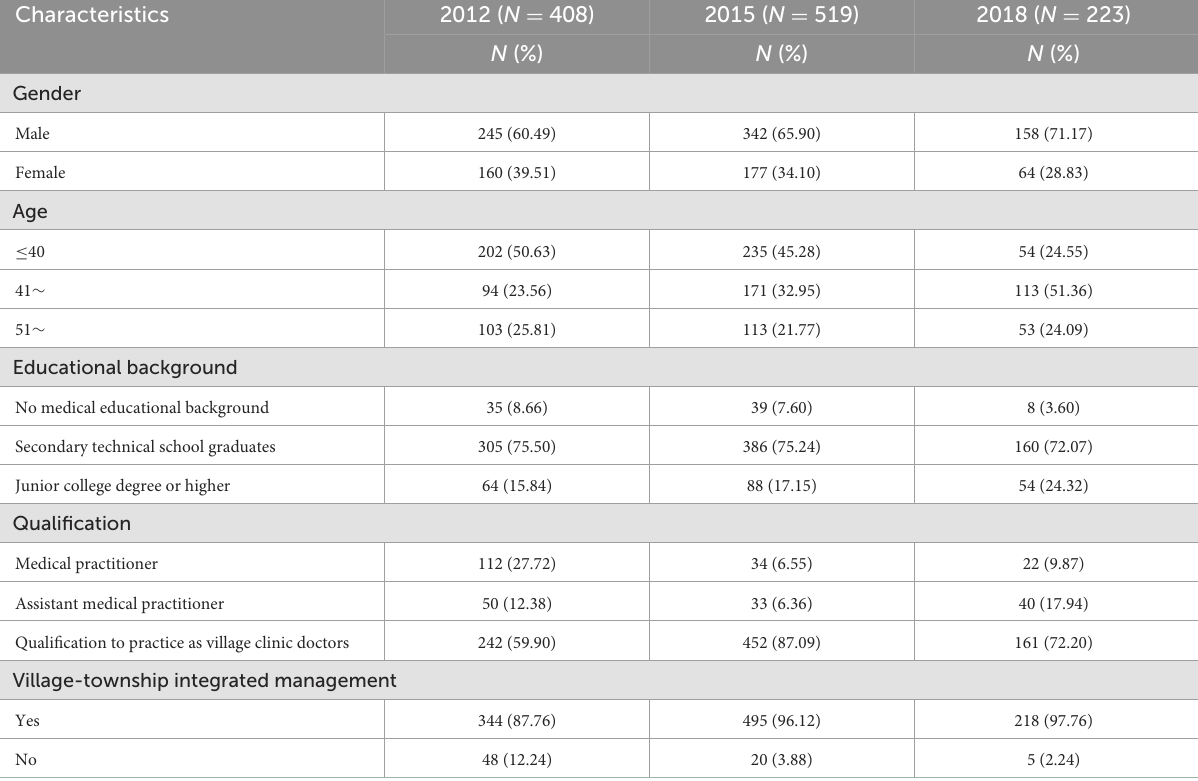
TABLE 1 Demographic characteristics of village clinic doctors from three